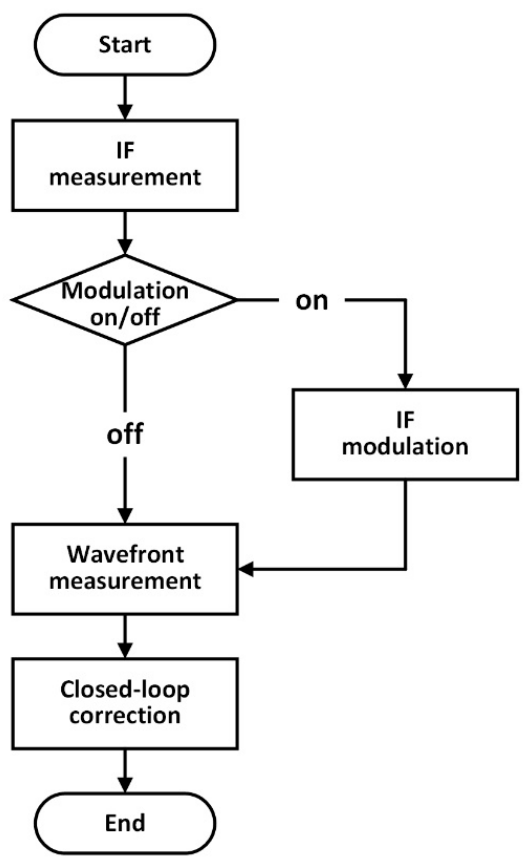
Figure 11. Wavefront correction process of the AO system.